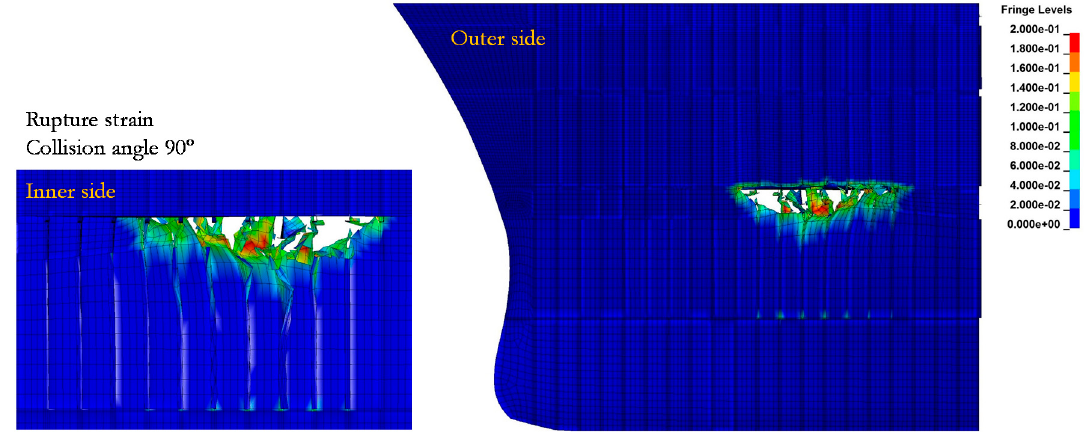
Figure 12. Contours of the strain near the car deck: Angle 90 ◦ .